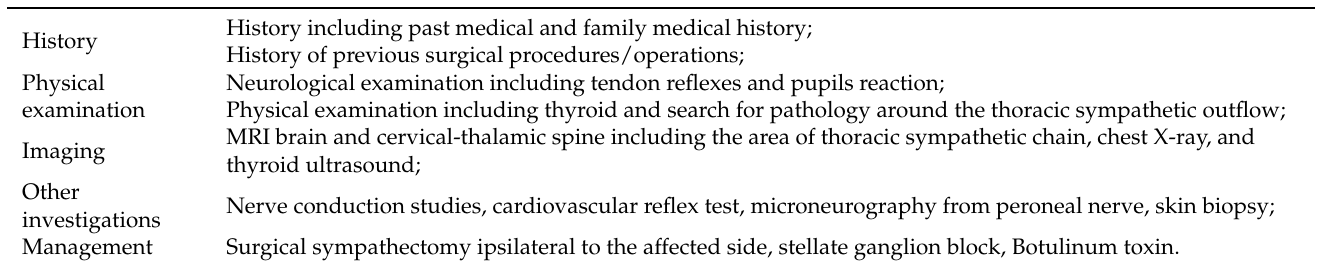
Table 2. Assessment and management of Harlequin